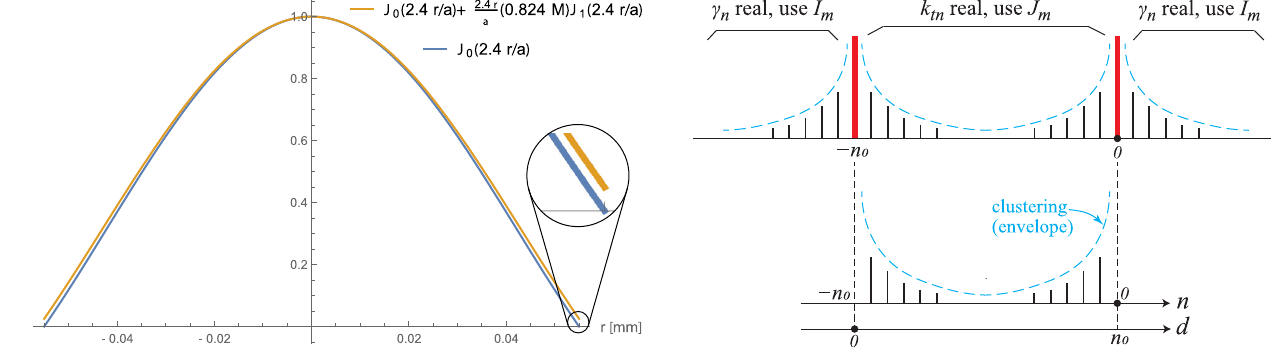
axis.FIG. 12. A comparison between the real part of the field the edges, compared to the real function J 0 ð 2 . 4 r=a Þ